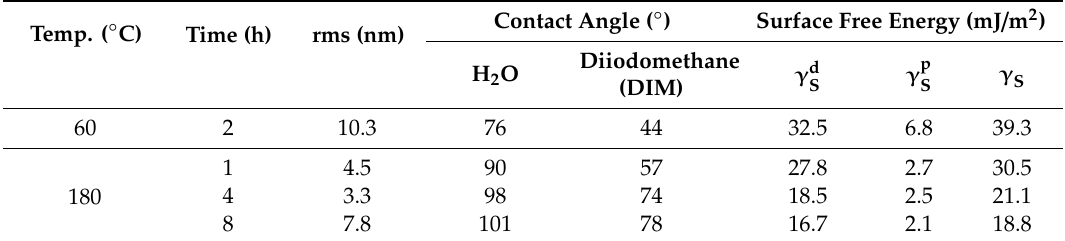
Table 1. Root-mean-square surface roughness, advancing contact angles for water and diiodomethane, and surface free energies of poly(vinyl phenol) prepared in tetrahydrofuran (PVPH-T). Contact Angle ( ◦ ) Temp. ( ◦ C) Time (h) rms (nm)